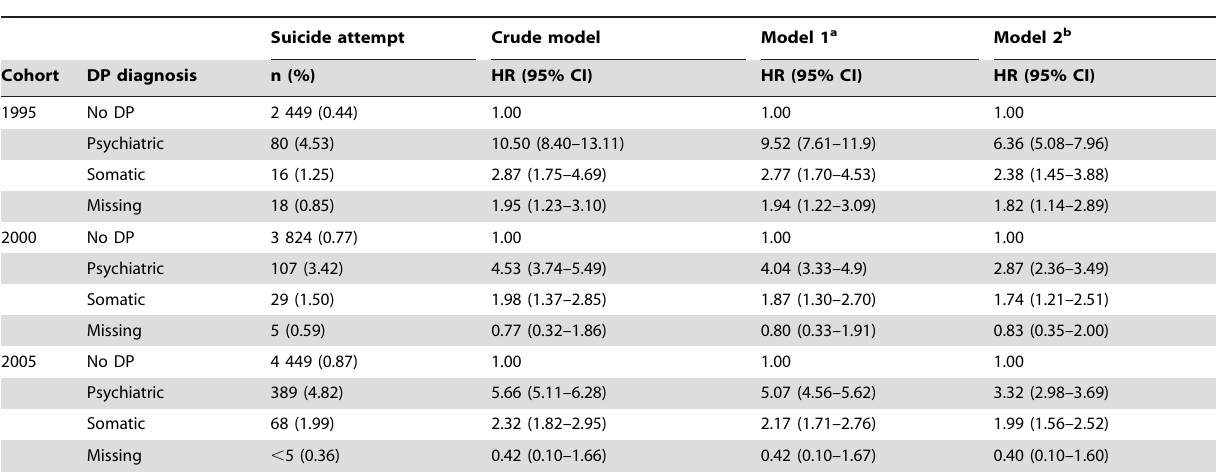
Table 5. Hazard ratios (HR) and 95% confidence intervals (CI) for suicide attempt during a five-year follow-up of young adults with disability pension (DP) due to psychiatric, somatic, or missing diagnoses in 1995, 2000, and 2005, respectively 1